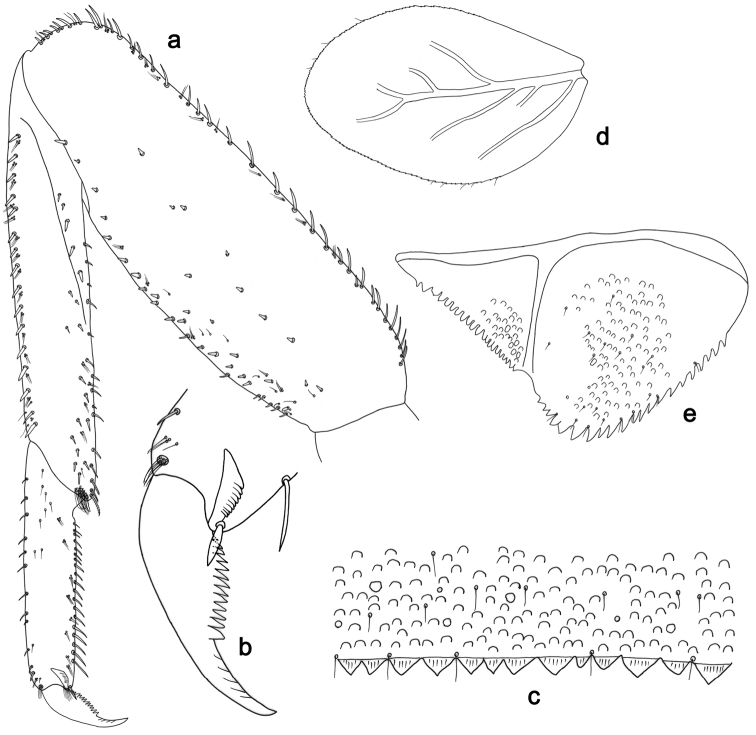
Labiobaetisgindroi sp. n., larva morphology: aForelegb Fore claw cTergum IV d Gill IV eParaproct.